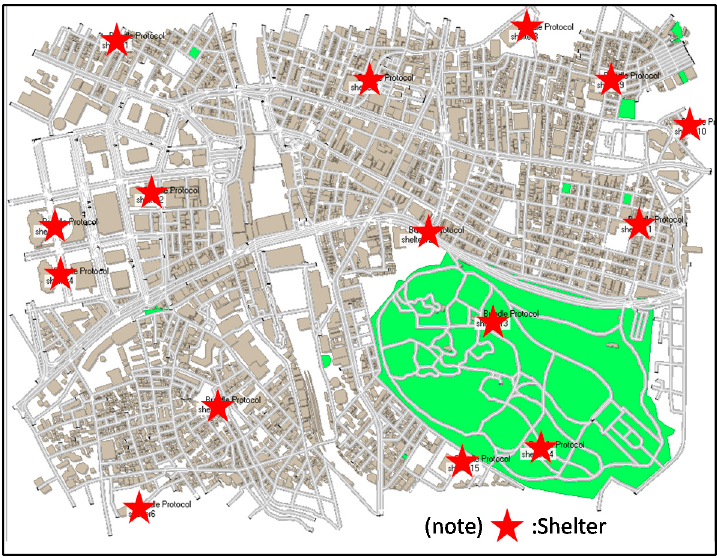
Figure 8. Simulation execution environment modeled on an area around Shinjuku Station.